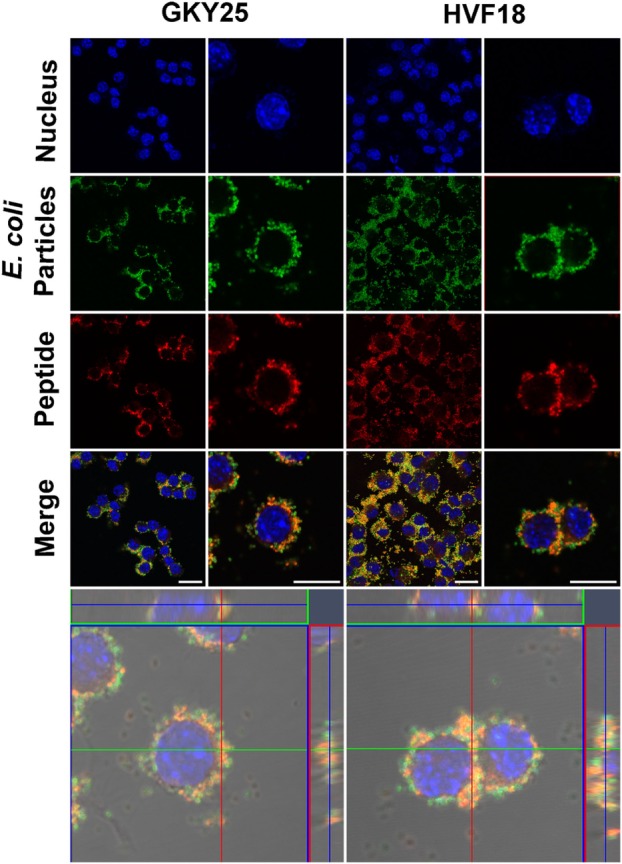
Phagocytosis of Escherichia coli BioParticles with bound thrombin-derived C-terminal peptides (TCPs) by RAW 264.7 cells. E. coli BioParticles were incubated with GKY25 (2 µM) or HVF18 (20 µM) for 1 h before addition to RAW 264.7 cells. Next, cells were fixed, stained and analyzed via confocal microscopy using Zeiss LSM software. Nucleus DNA was stained with DAPI (blue), E. coli BioParticles are green, and TCPs were labeled with VFR17 antibody and Alexa 568 (red). The left panel shows an overview, and the right panel shows a higher magnification of the cells. The lower panel displays a z-stack of the RAW 264.7 cells with a top view looking down to the cell (square) and a side view through the cell (right and above). One representative image out of three independent experiments is shown. Scale bar, 10 µm.